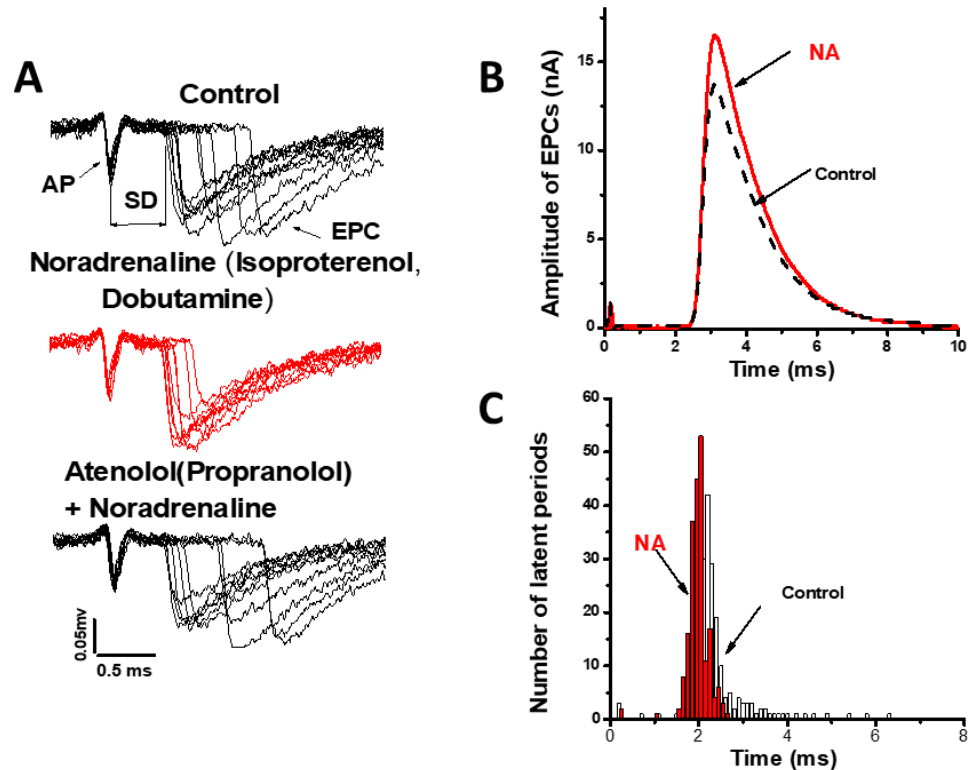
Figure 2. Noradrenaline and β 1 adrenoceptors agonists effects at frog NMJ. ( A ) decrease of the synaptic delays (SD) fluctuations of extracellular uni-quantal EPCs (end plate currents) in the presence of noradrenaline or agonists of β 1 adrenoceptors (middle panel), synaptic delays after noradrenaline addition in presence β 1 adrenoceptor blockers; ( B ) intracellular multi-quantal EPC has higher amplitude after noradrenaline application without increase of EPC quantal content; ( C ) histograms of synaptic delays distributions in control and after noradrenaline application. AP—axon action potential;